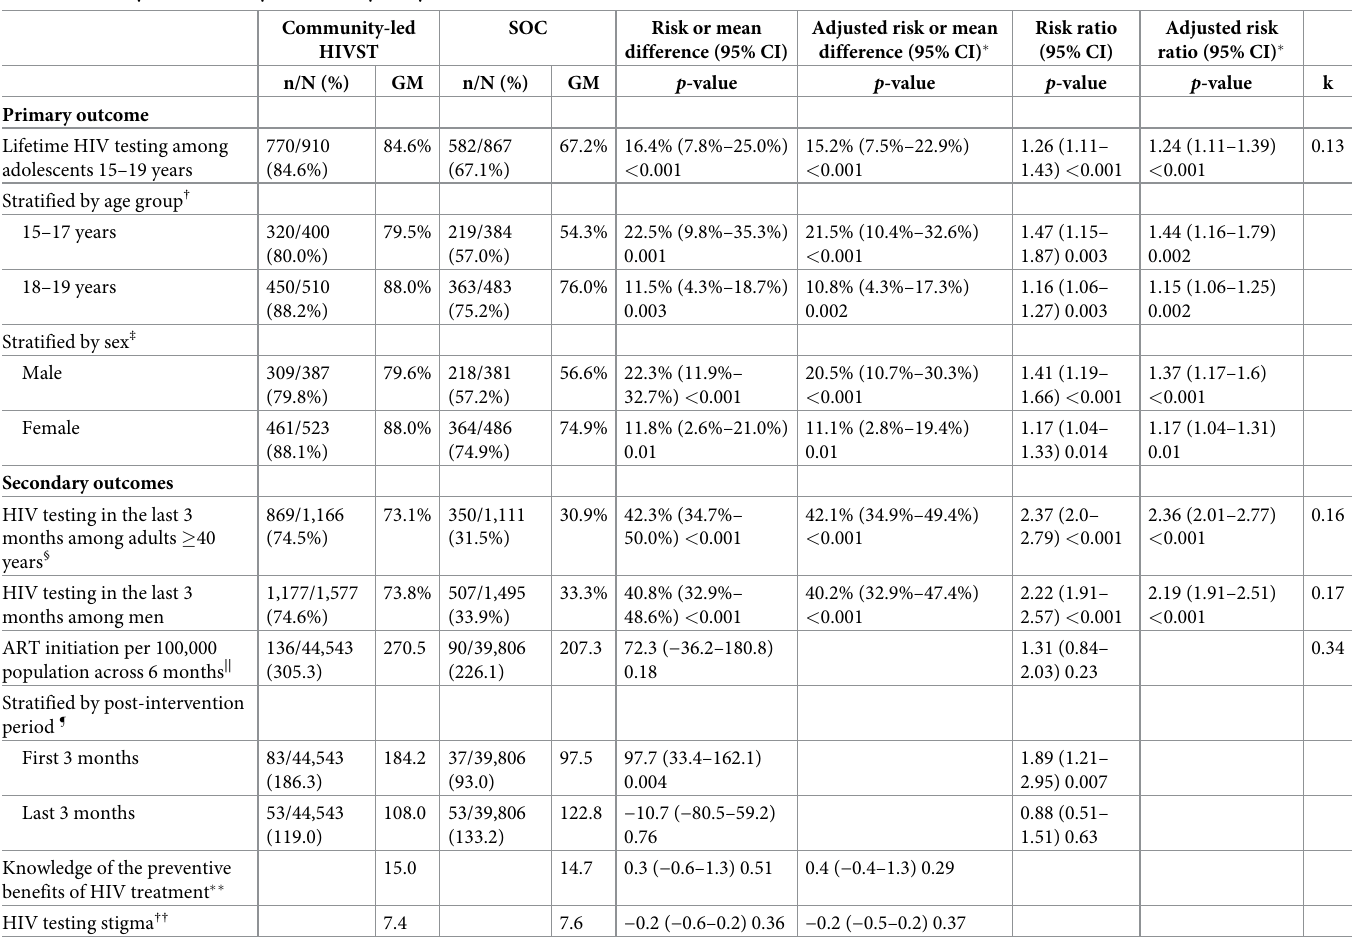
Table 3. Primary and secondary outcomes by study